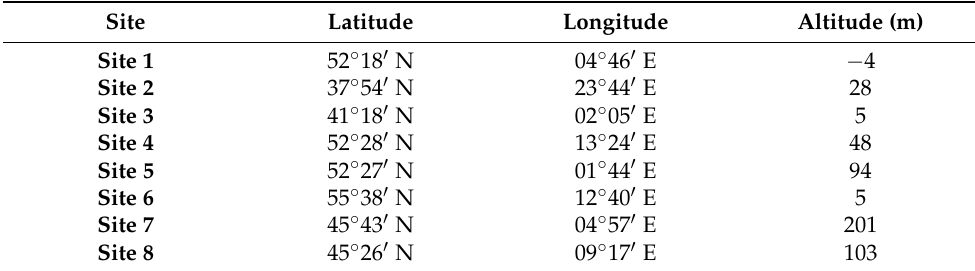
Table 2. Geographical data for the eight sites considered (data from